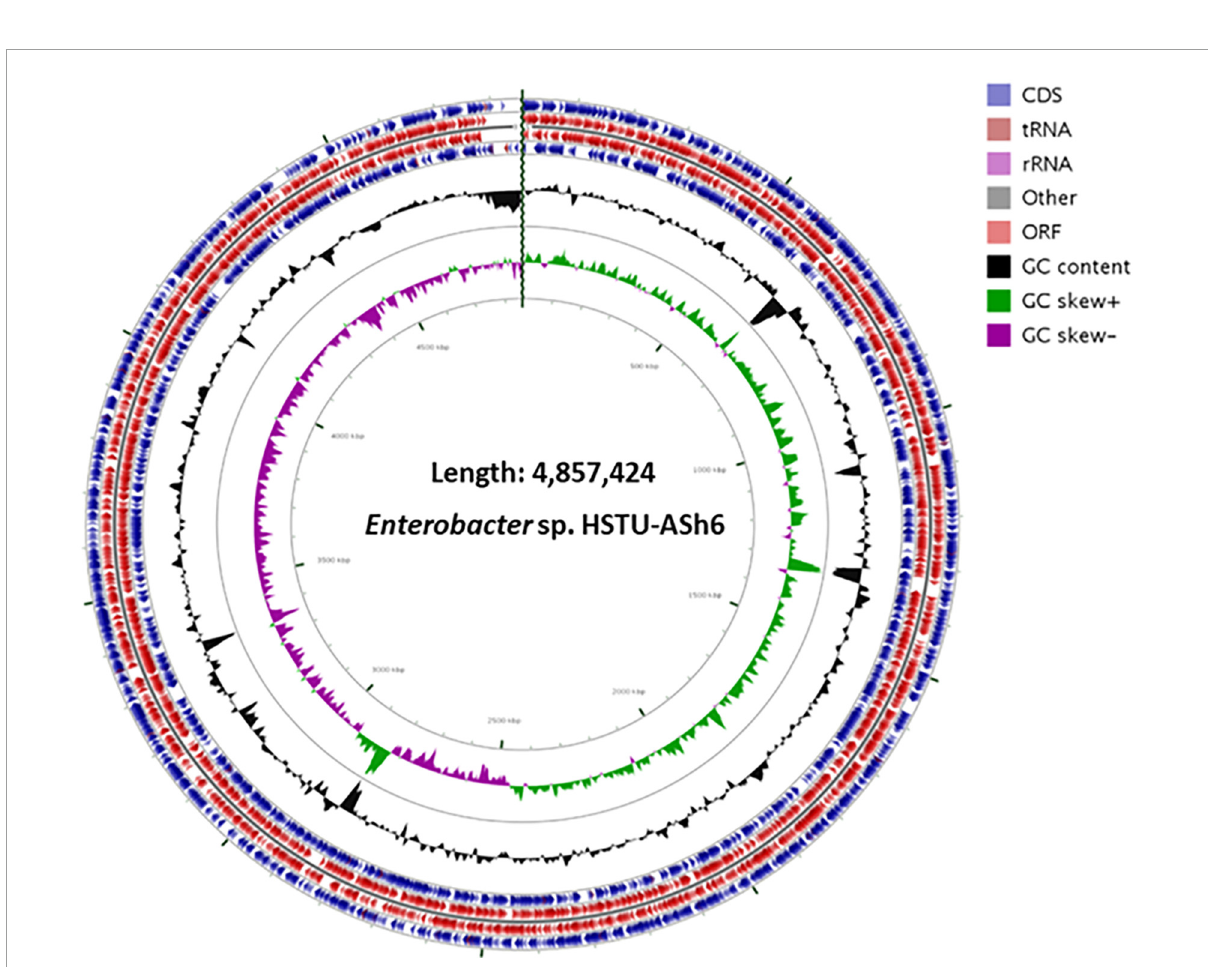
FIGURE2 CDS map of the annotated genome of Enterobacter sp.